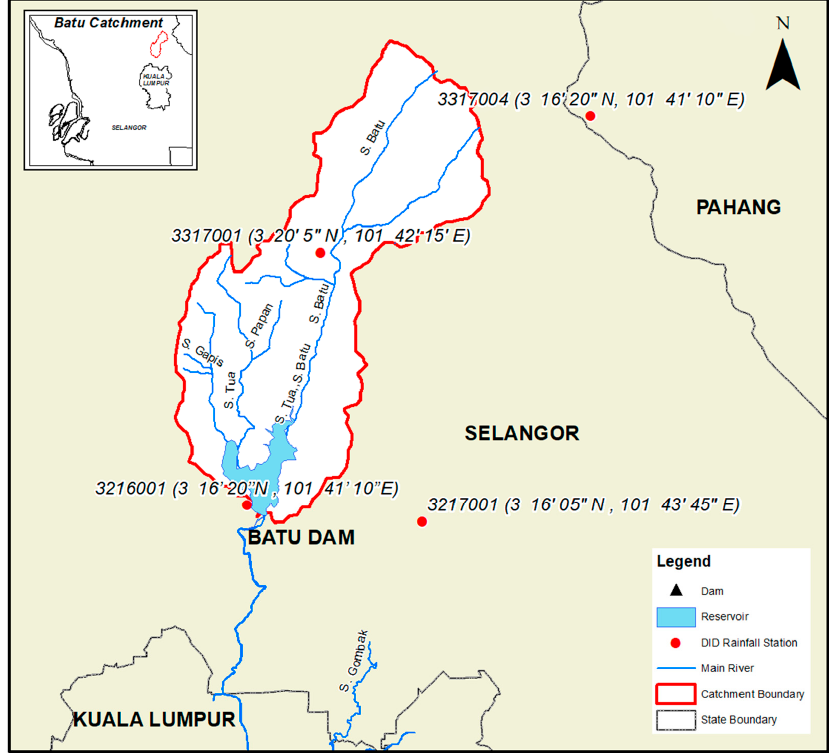
Figure 7. Rainfall stations within the Batu Dam catchment.